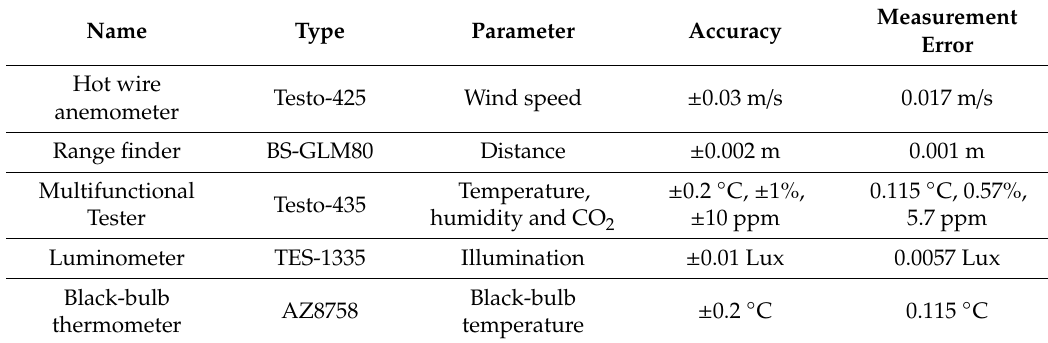
Table 3. Parameters of the